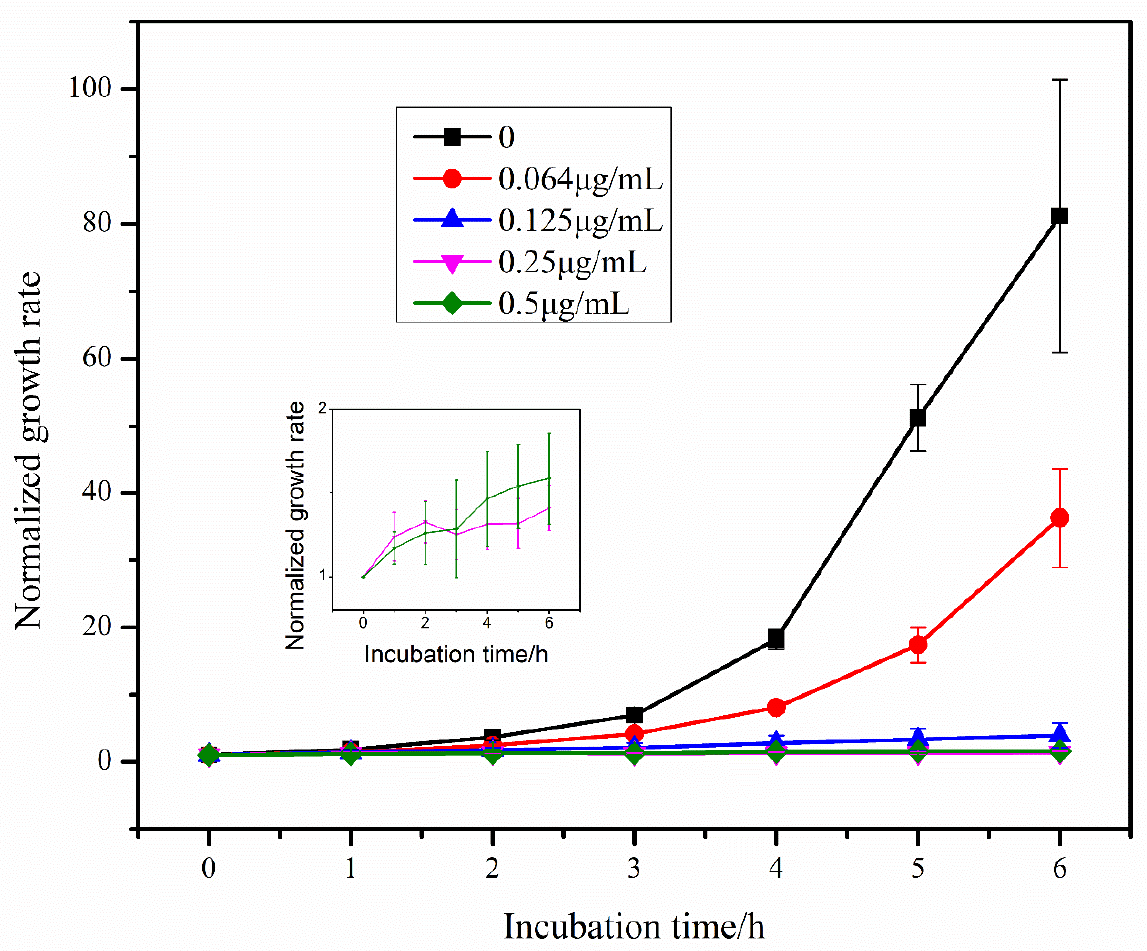
Figure 6. Growth rate of E. coli over time under the effect of different concentrations of tigecycline. Since the growth rate of E. coli did not change significantly under the effect of 0.25 μg/mL and 0.5 μg/mL tigecycline, we show the growth rate curves of E. coli under the effect of these two concentrations of tigecycline separately in the figure.